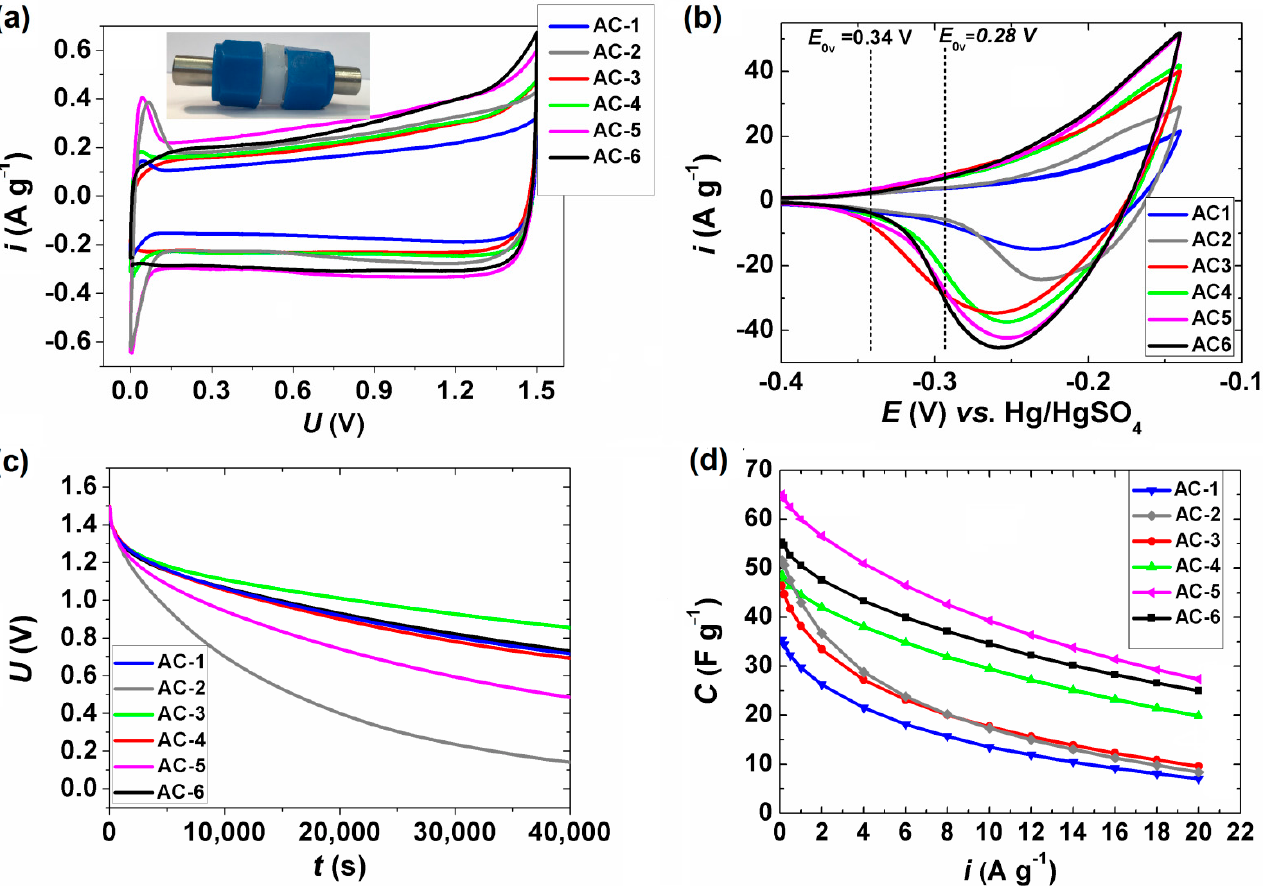
Figure 1. ( a ) Cyclic voltammetry profiles (0.005 V s − 1 ) of KI-REHES Swagelok ® -type cells fabricated from different ACs electrodes. ( b ) Cyclic voltammetry characteristics (at 0.005 V s − 1 ) recorded in the three-electrode cell for the ACs electrodes in the presence of KI electrolyte. ( c ) Capacitance changes as a function of discharge current and ( d ) self-discharge profiles for different ACs-based REHES